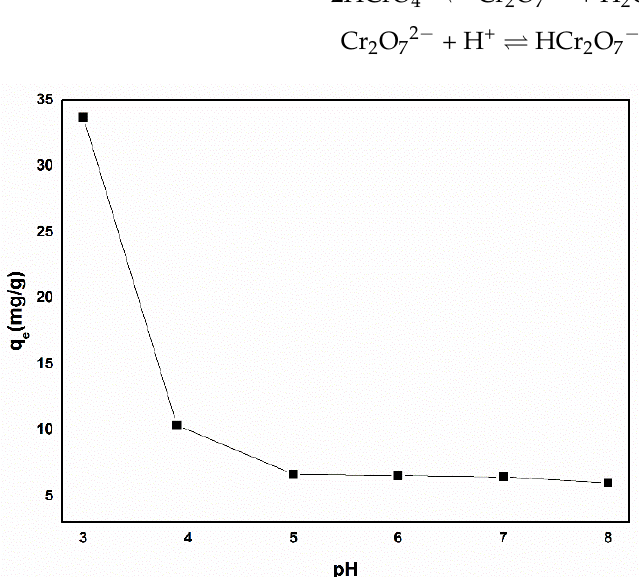
Figure 8. The effect of pH on the Cr(VI) adsorption capacity of Fe/CA .